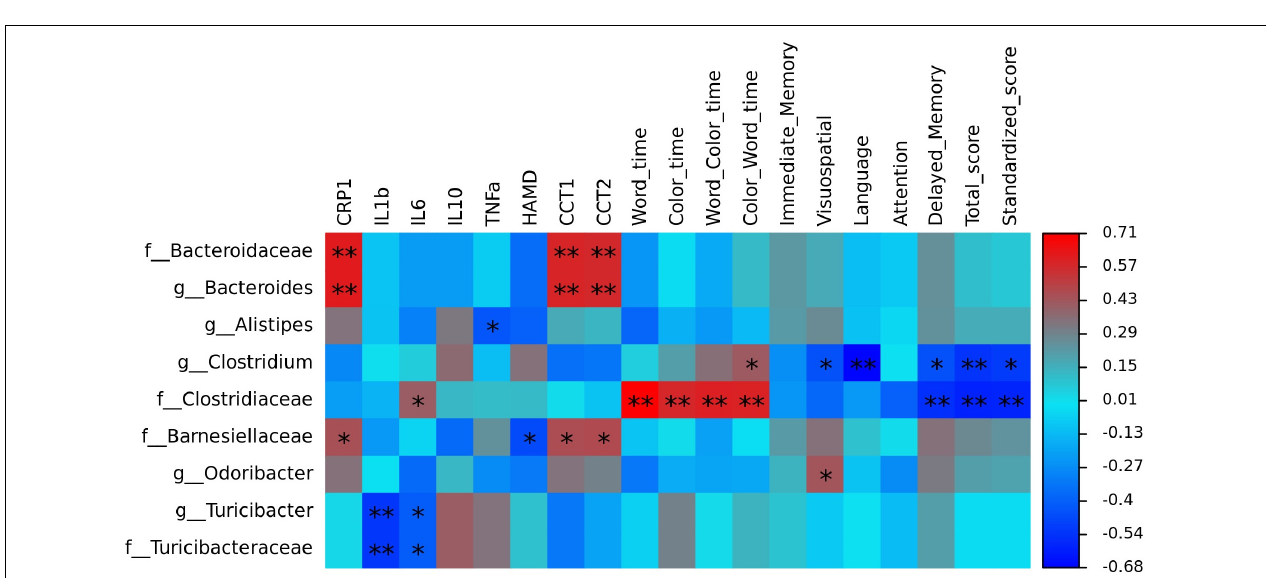
FIGURE 6 | The scatter plot of correlation between Clostridiaceae, Turicibacteraceae abundance, and the HAMD-17 scores in two groups.